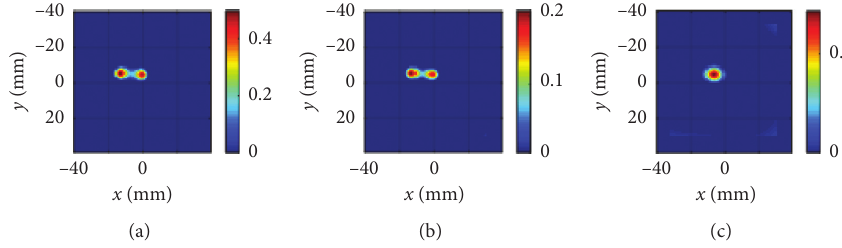
Figure 4: The imaging results of two scatterers